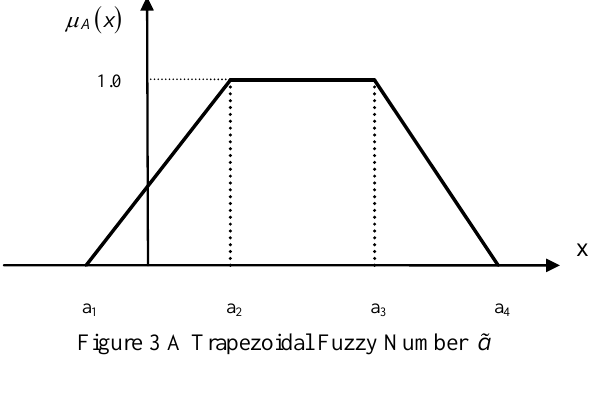
Figure 3 A Trapezoidal Fuzzy Number